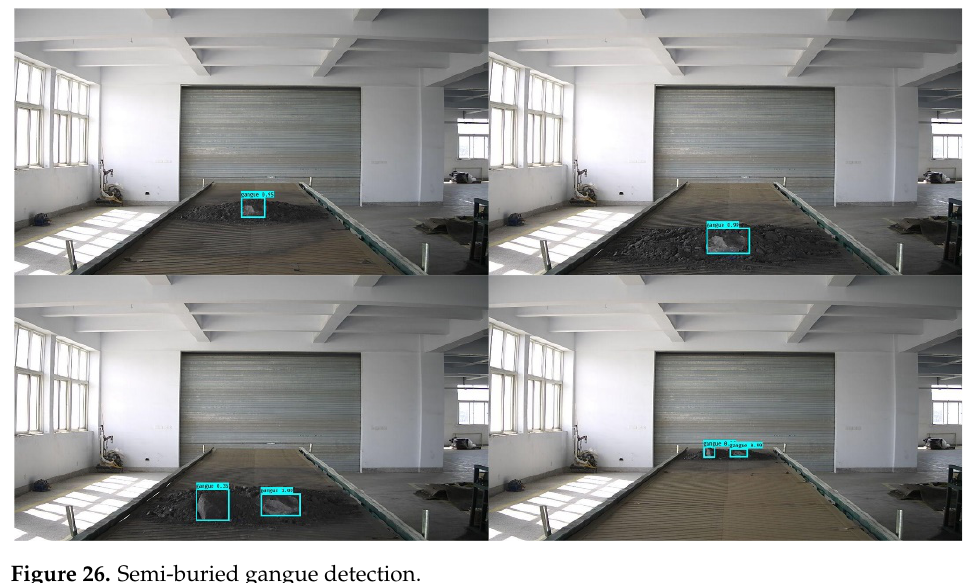
Figure 26. Semi-buried gangue detection.